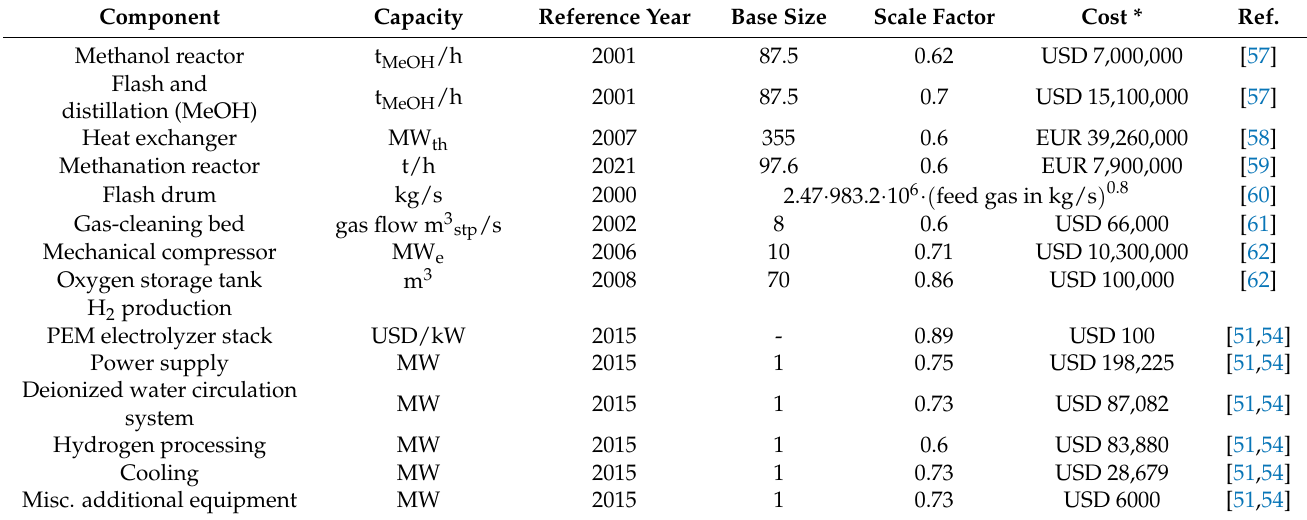
Table 6. Equipment cost data.